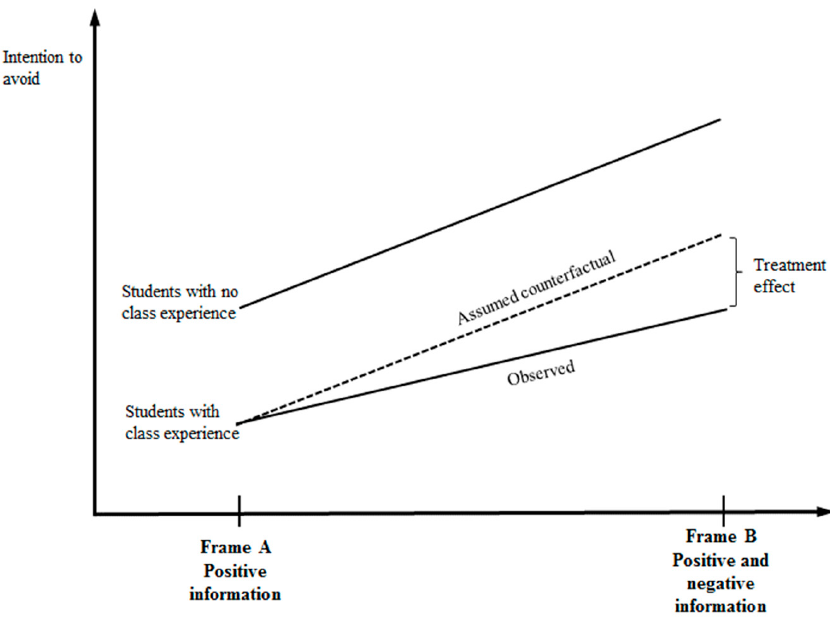
Figure 2. Estimation strategy for the treatment effect based on assumed counterfactual.